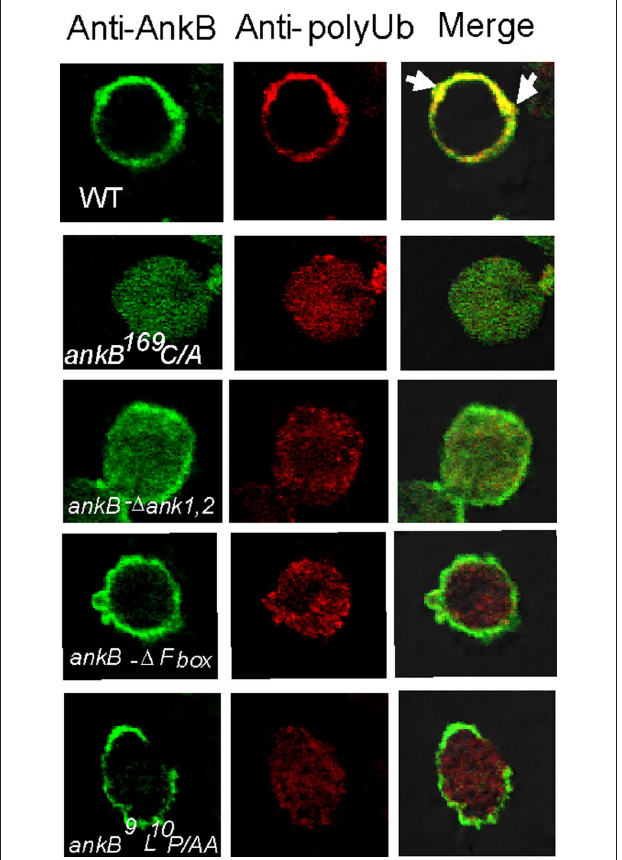
FIguRe 1 | Biological function of AnkB as platforms for the recruitment of polyubiquitinated proteins to the plasma membrane of AnkB- transfected D. discoideum . D. discoideum was transfected with the FLAG-AnkB, or FLAG-AnkB 169 C/A, FLAG- ∆ AnkB1,2, FLAG- ∆ F-box, or AnkB 9 L 10 P/AA. Localization of FLAG-AnkB fusion proteins was examined by confocal laser scanning microscopy. Cells were labeled with anti-AnkB antibodies (green) and anti-polyubiquitin antibodies (red). The data are representatives of three independent